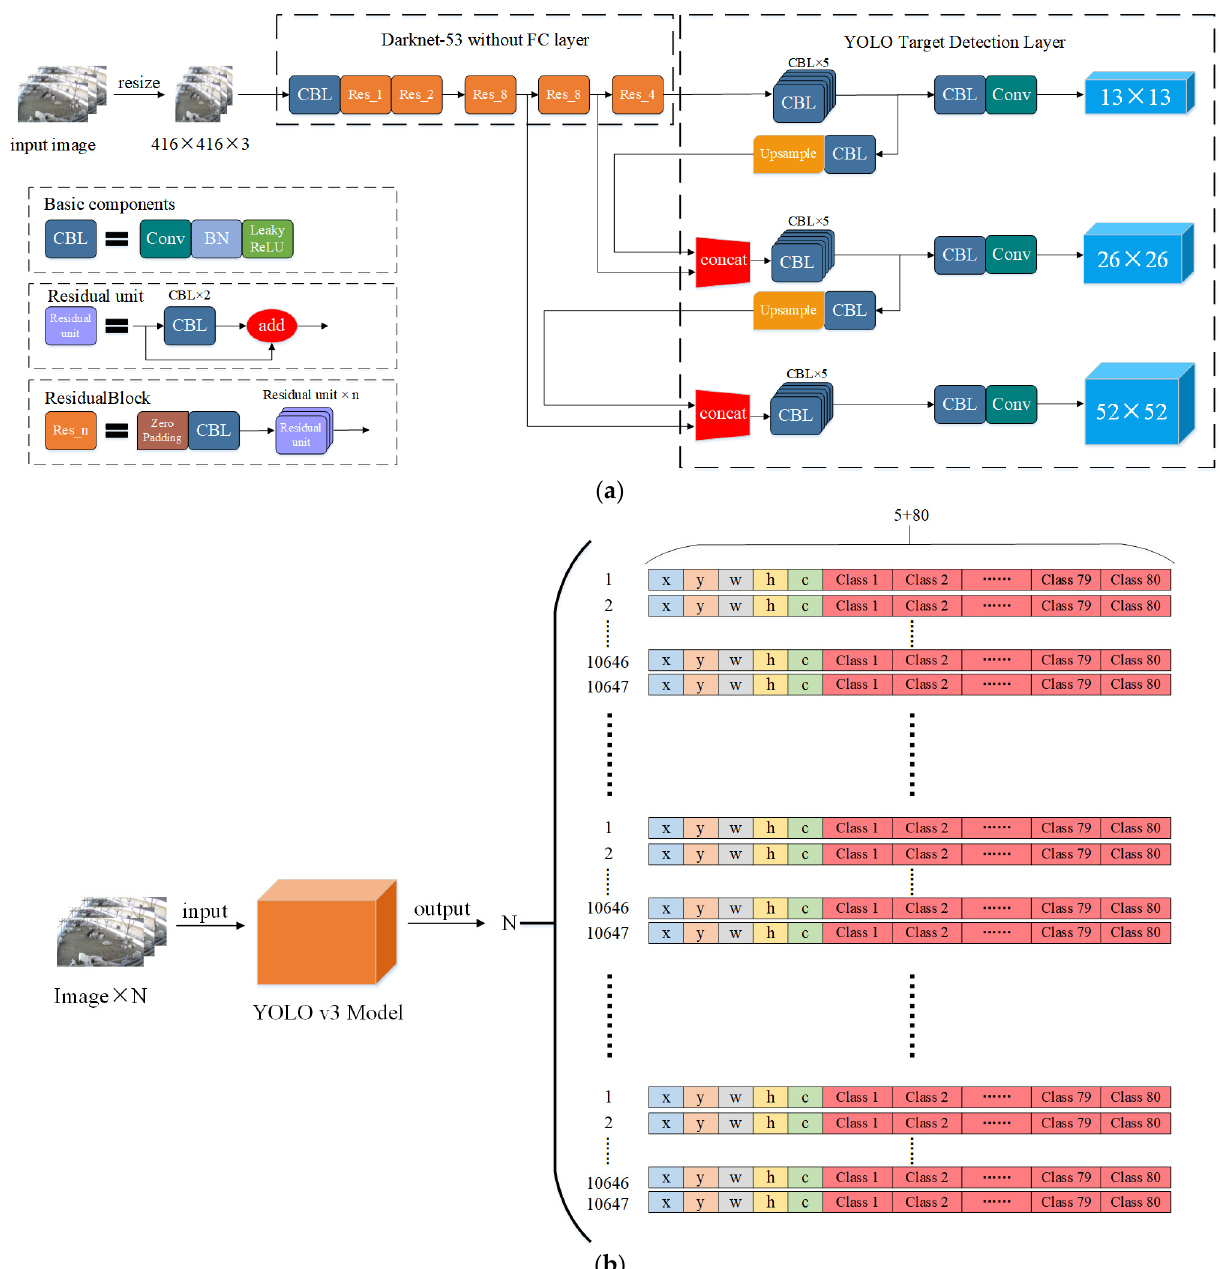
Figure 5. Structure and output of YOLO v3 model: ( a ) Structure of YOLO v3 model; ( b ) Output of YOLO v3 model.